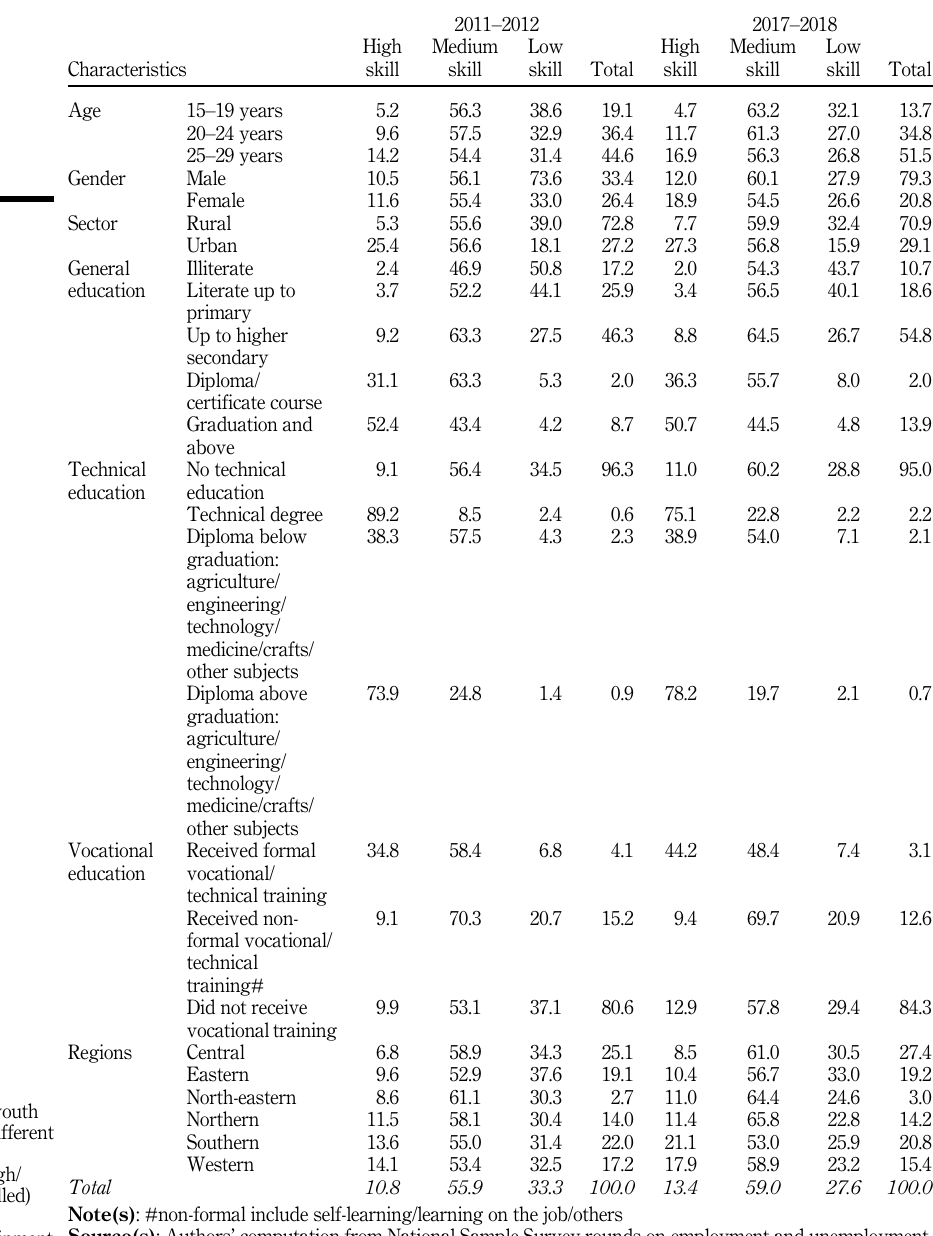
Table 1. Distribution of youth employed in a different category of occupations ( high/ medium/low skilled) with level of educational attainment (in